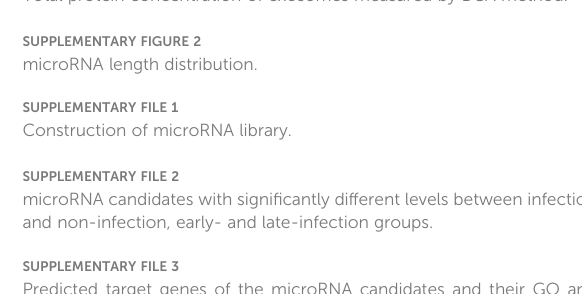
SUPPLEMENTARY FIGURE 1 Total protein concentration of exosomes measured by BCA method. SUPPLEMENTARY FIGURE 2 microRNA length distribution. SUPPLEMENTARY FILE 1 Construction of microRNA